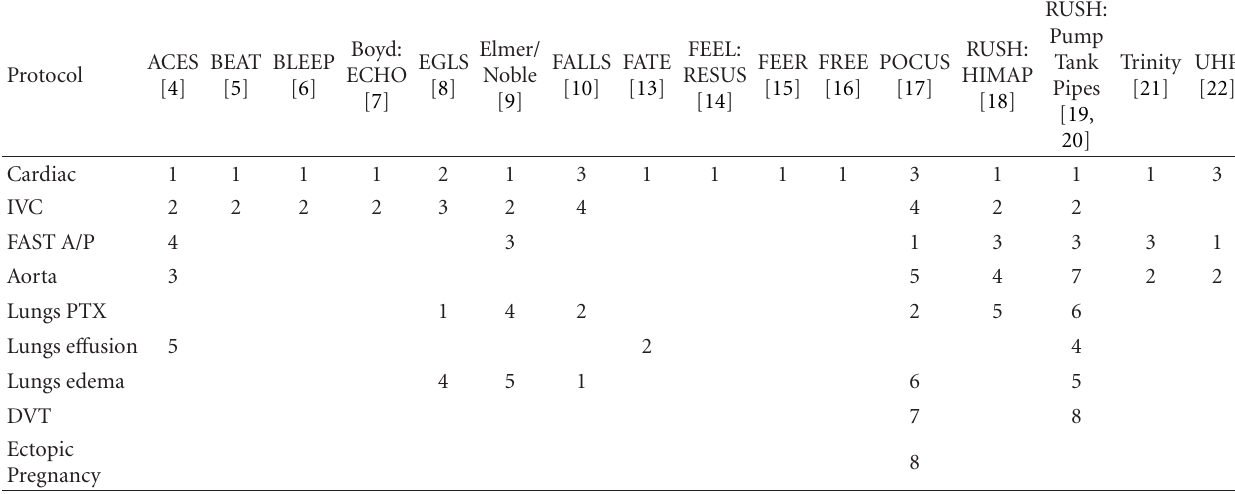
Table 3: Summary of the major ultrasound protocols for medical shock